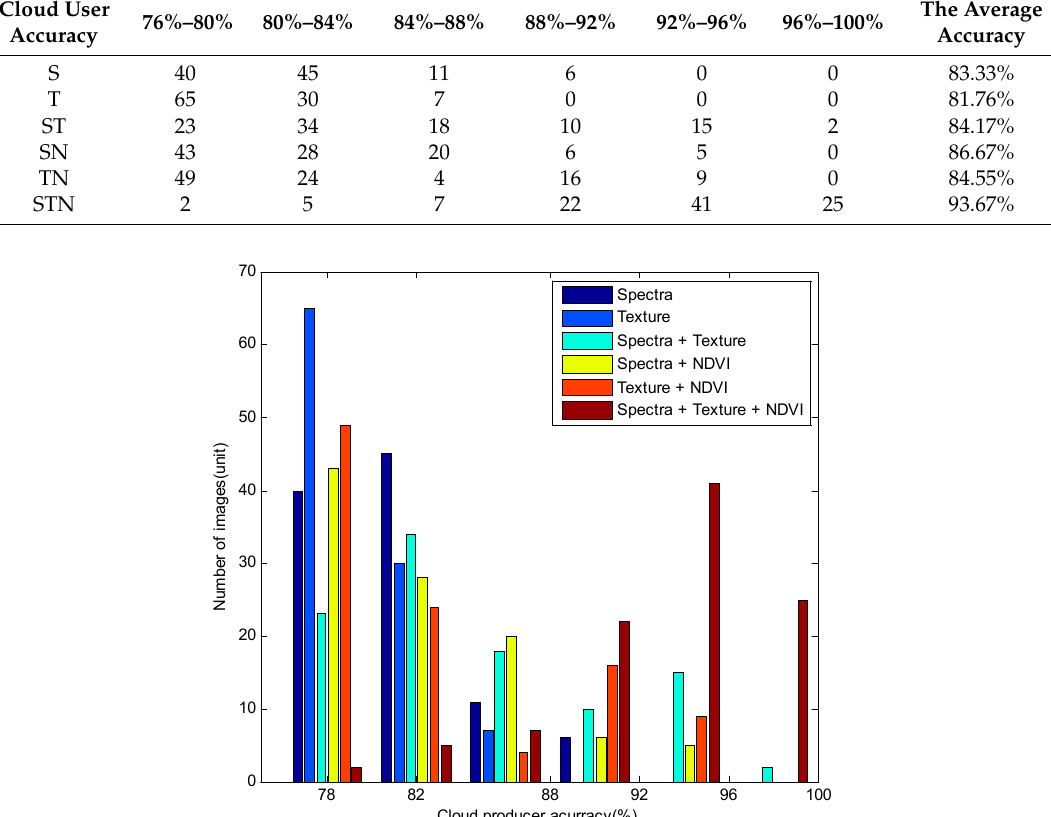
Figure 9. Bar of cloud producer accuracy for S, T, ST, SN, TN, and STN feature fusion on 102 GF-1/2 images.